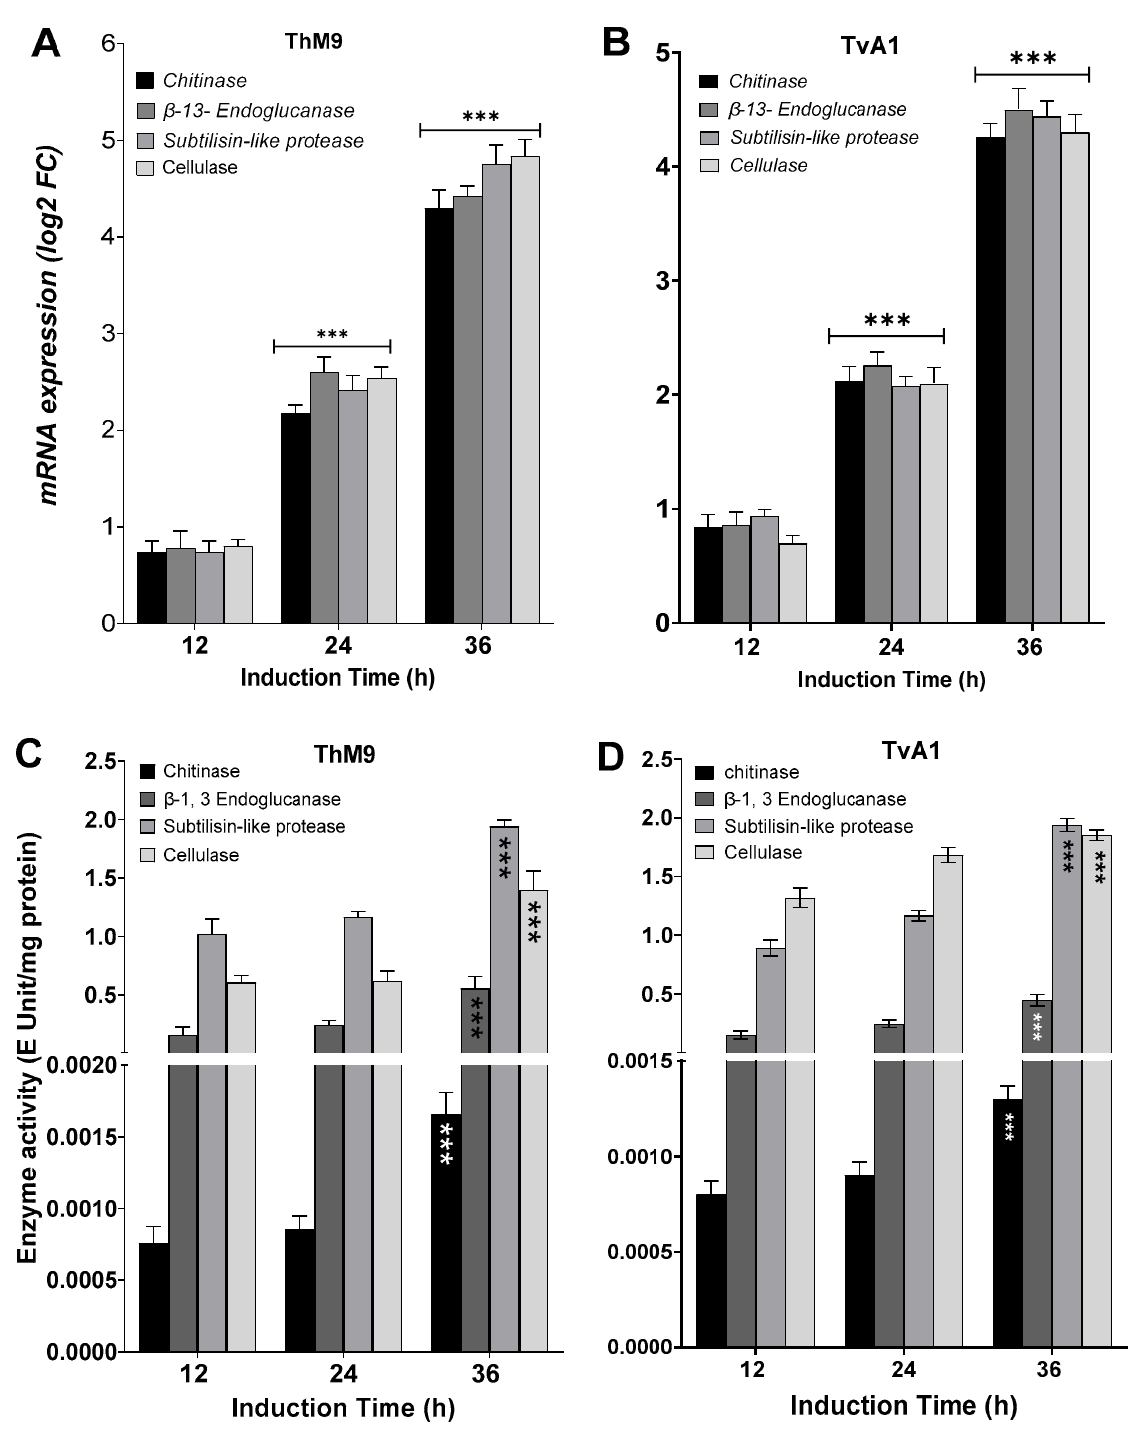
Figure 3. Induction of hydrolytic enzymes in ThM9 and TvA1 fungal isolates. ( A ) Expression of Chitinase, β -13-Endoglucanase, Subtilisin-like protease , and glycoside hydrolase enzymatic genes in ThM9. ( B ) Expression of Chitinase, β -13-Endoglucanase, Subtilisin-like protease , and glycoside hydrolase enzymatic genes in TvA1. ( C ) Chitinase, β -13-Endoglucanase, Subtilisin-like protease , and glycoside hydrolase enzymatic activities in ThM9. ( D ) Chitinase, β -1,3-Endoglucanase, Subtilisin-like protease , and glycoside hydrolase enzymatic activities in TvA1. Quantitative data represent the means ± SD (n = 12) of three independent experiments. The asterisks indicate represents a significant difference between treated samples compared to control (*** p ≤ 0.005).